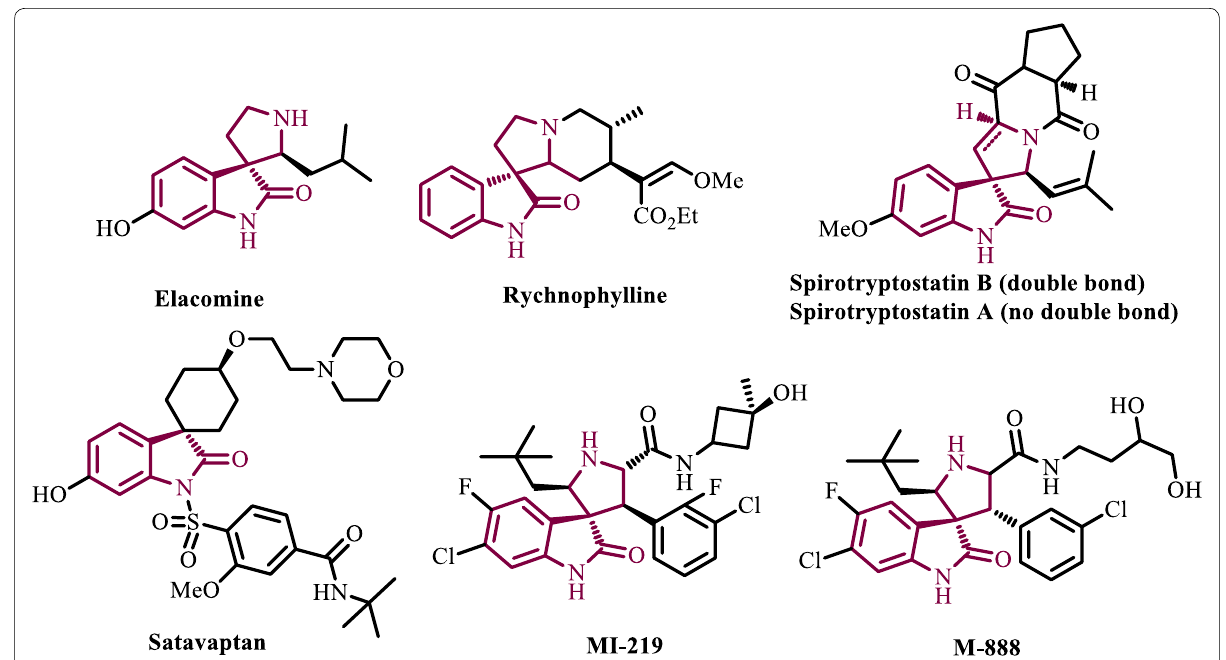
Fig. 1 Representative biologically relevant natural spiro(oxindole‑pyrrolidine)